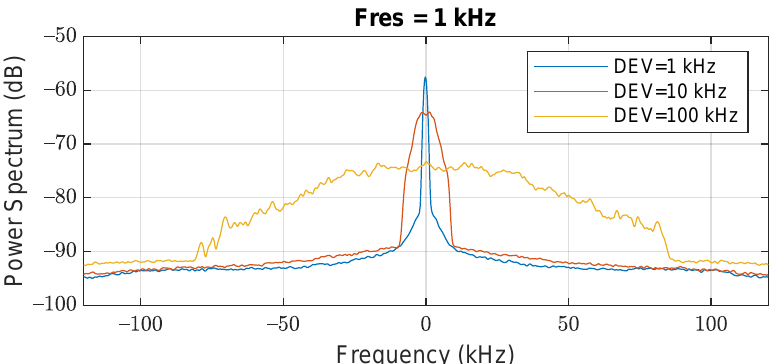
Figure 13. Measured power spectra at the output of Adalm Pluto. DEV—FM deviation. The transmitted power of Adalm Pluto is − 26 dBm, and the receiver gain is 10